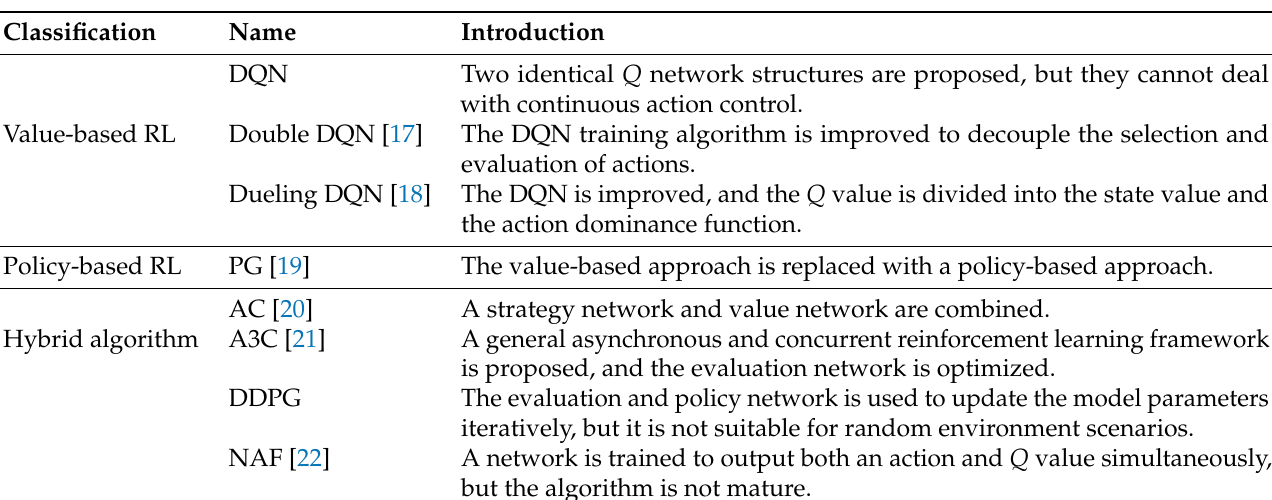
Table 1. Summary of DRL